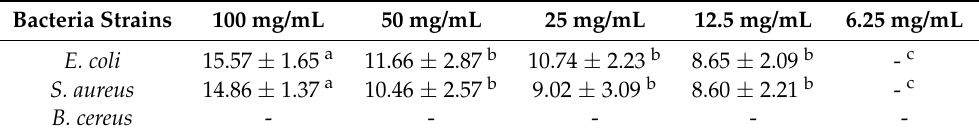
Table 1. The DIZ of three strains of IHLE in different concentrations (mm). Bacteria Strains